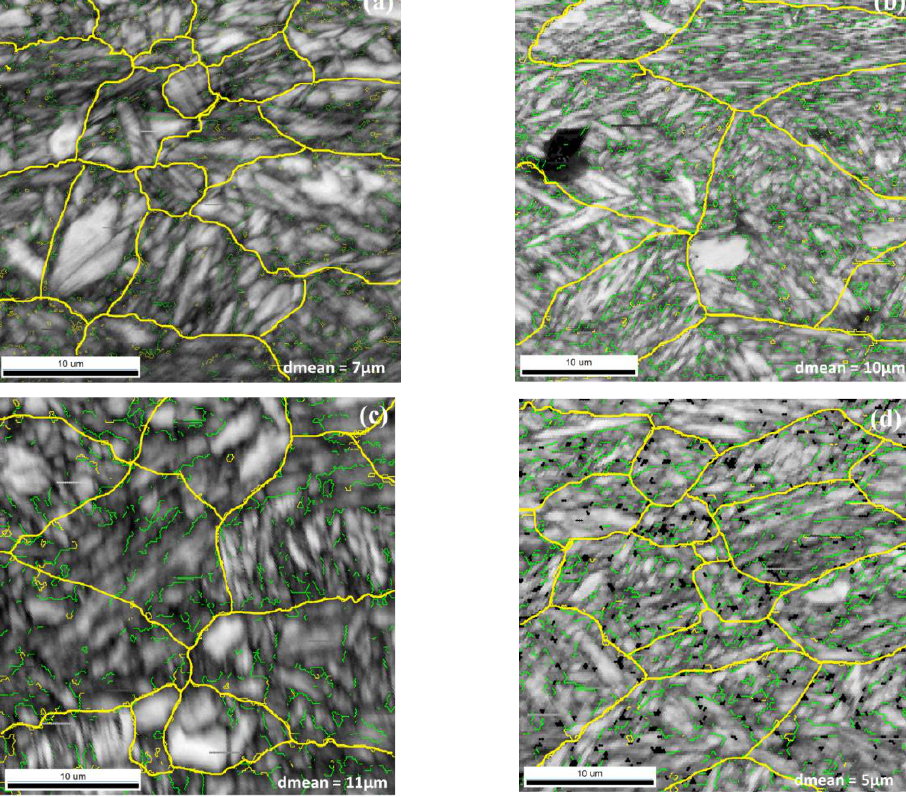
Figure 4. Misorientation map obtained from EBSD from ( a ) FP_10, ( b ) FSC_10, ( c ) FP_200 and ( d ) FSC_300 showing the mean values of PAGS. The green lines indicate misorientation angles of 50–60° which correspond to bainitic ferrite laths.